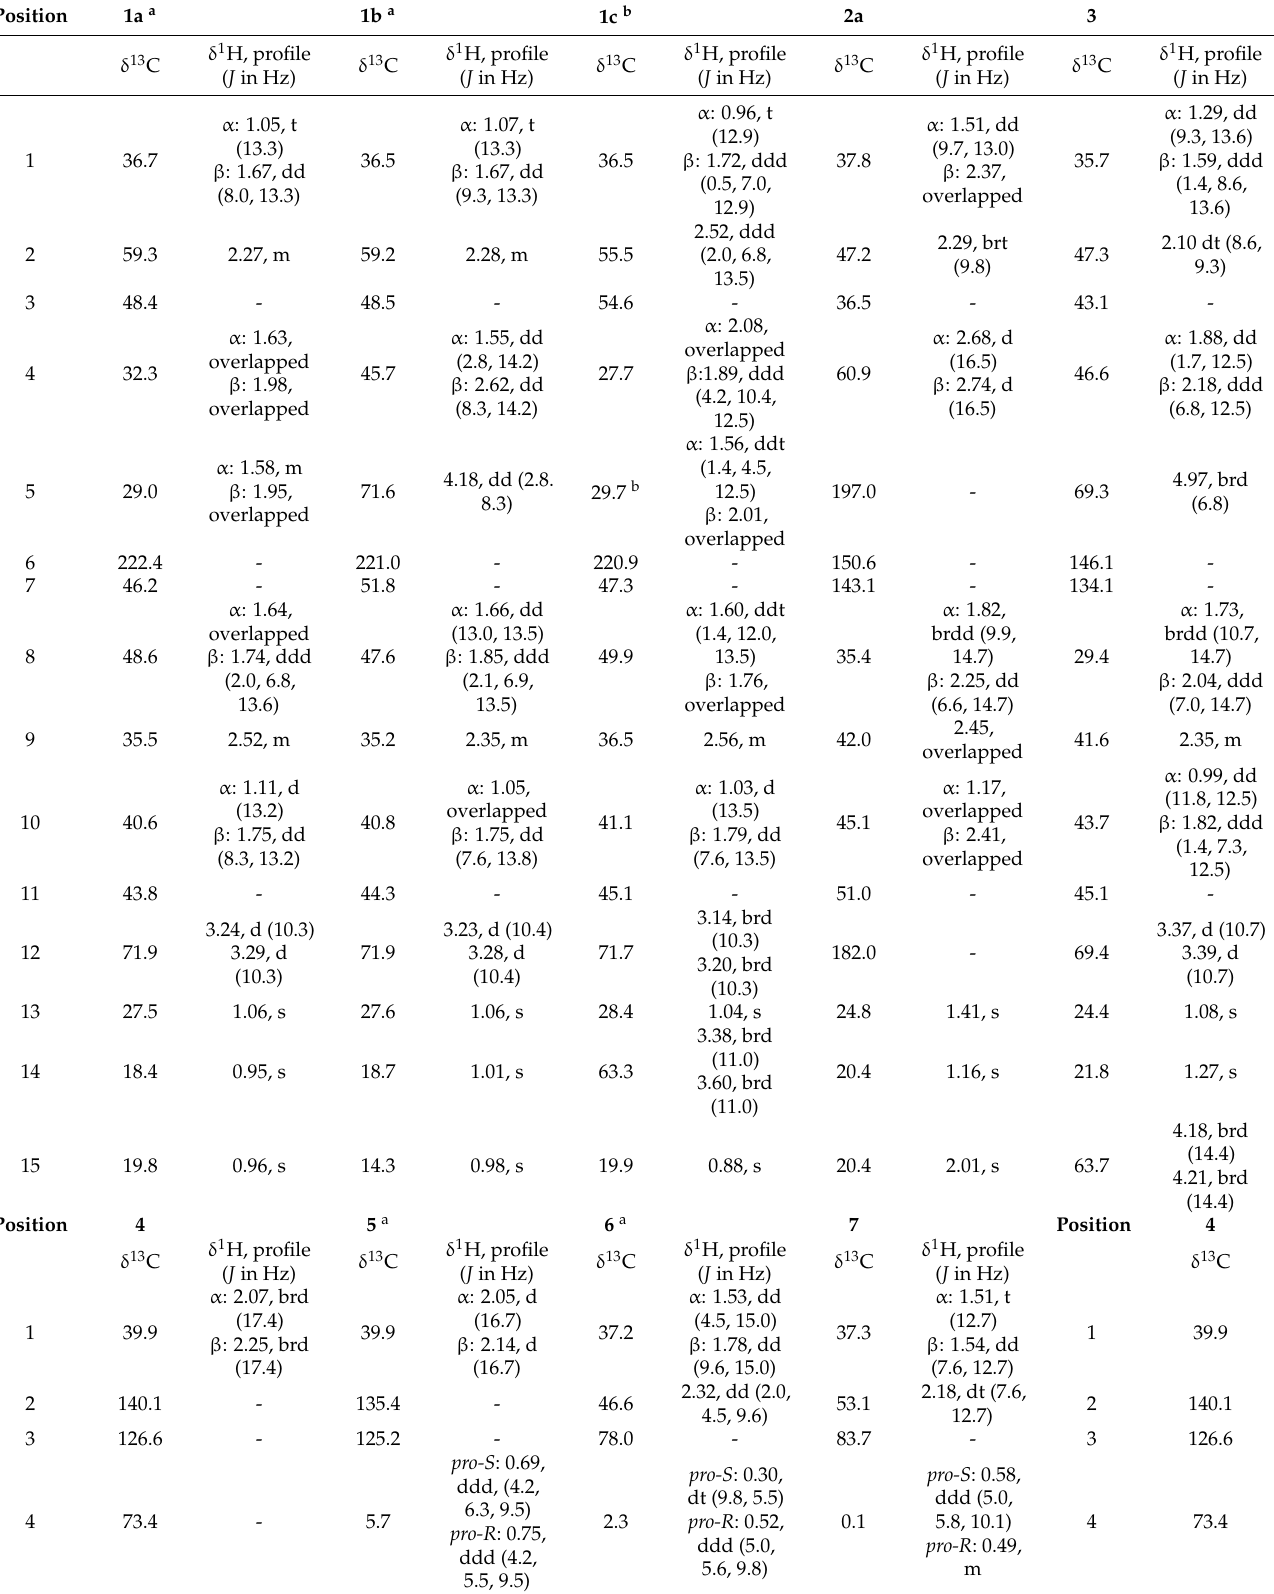
Table 1. Summary of 1 H NMR spectral data ( δ H , type ( J in Hz)) in CDCl 3 (500